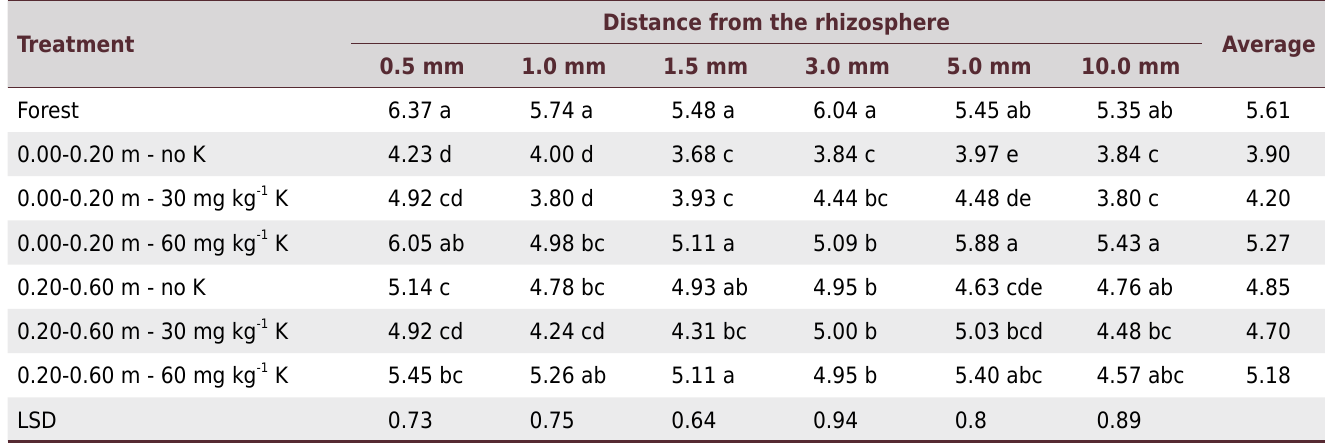
LSD = least significant difference (p<0.05). Lower case letters compare treatments within